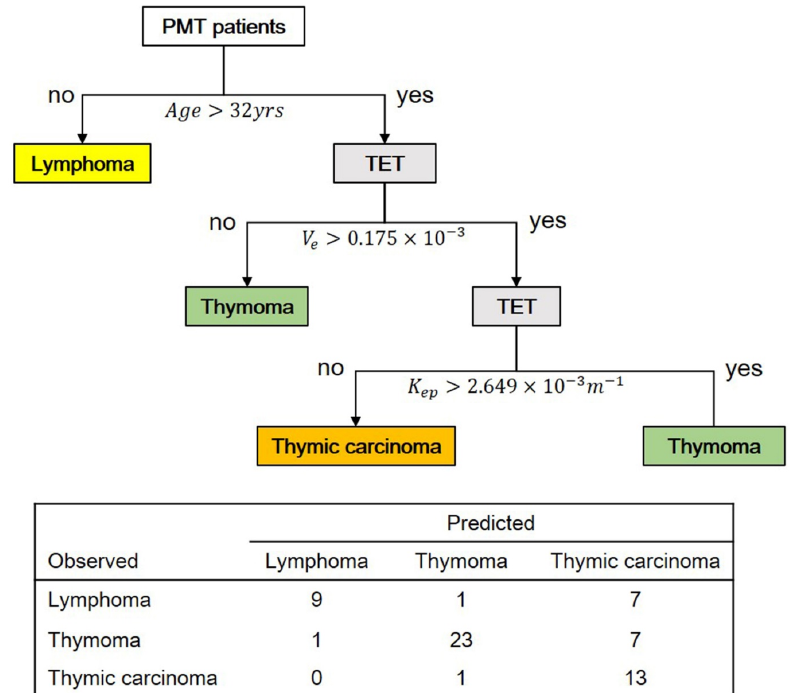
Figure 3. The predictive model for differentiating three PMT subtypes (lymphoma, thymoma, and thymic carcinoma) based on 62 PMT patients. The total predictive accuracy was 72.58%. Abbreviation: TET = thymic epithelial tumor.